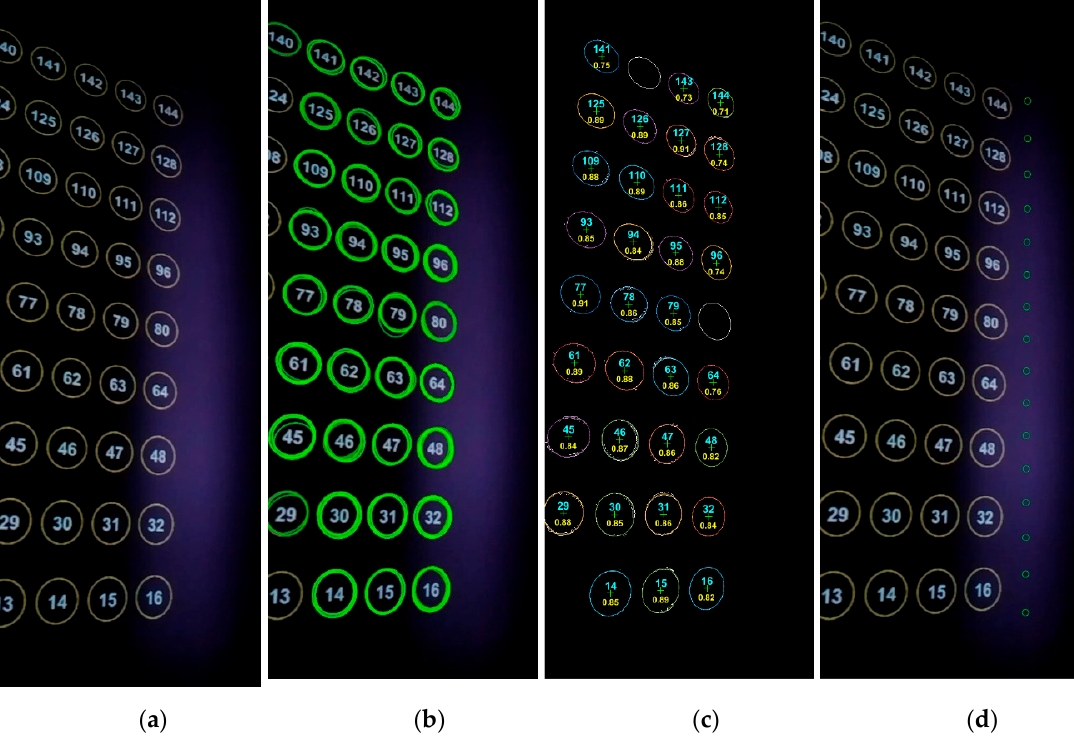
Figure 5. Calibration processing of an example frame: ( a ) circle grid (yellow) and LED light (purple) from camera view, ( b ) ellipse detection (green) by CNED method, ( c ) fine ellipse fitting (random color), ellipse ID from OCR (cyan) and OCR confidence (yellow), and ( d ) calibrated segment points reprojected to the frame image (green).